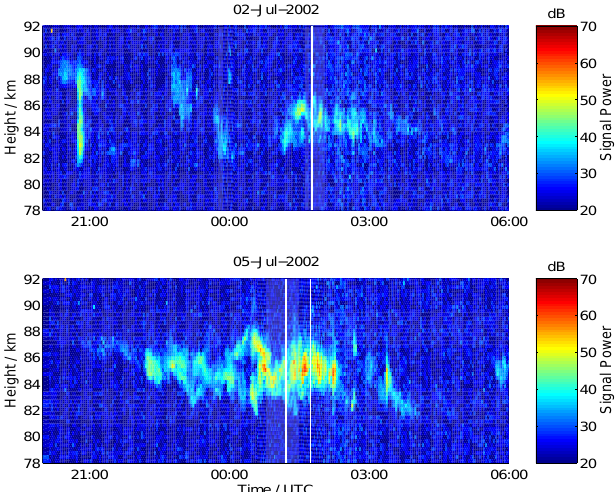
Fig. 4. Aspect sensitivity parameter calculated from the mean signal power for the three rocket flights. The white area defines the region where the SNR is larger than